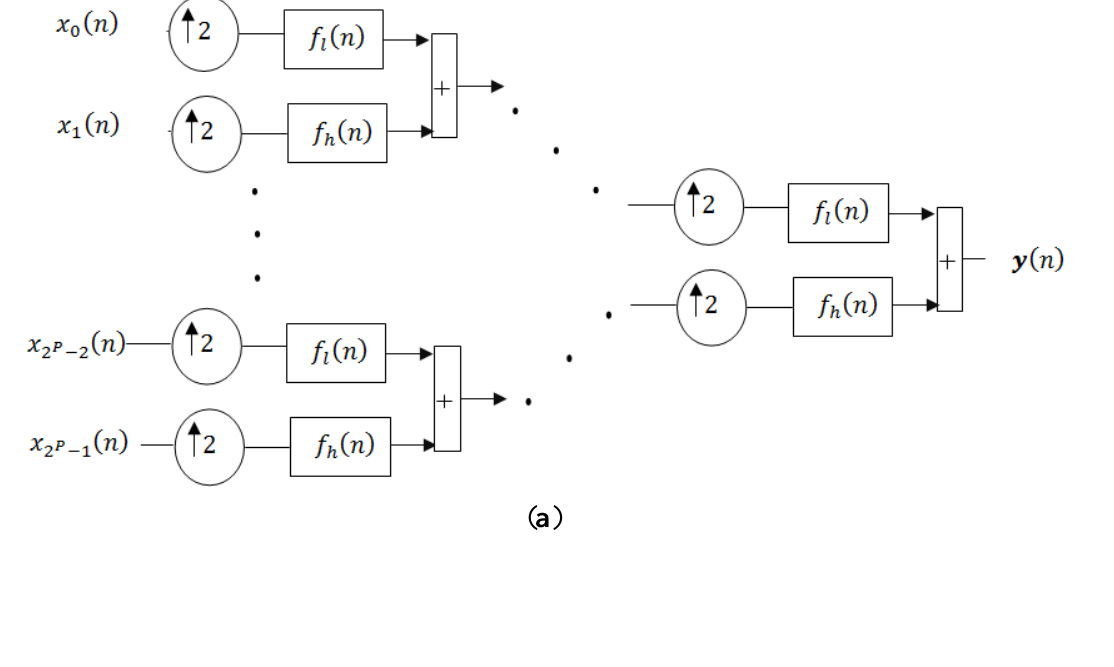
Figure 1. Symmetric multistage WOFDM modulator and demodulator. ( a ) Symmetric multistage synthesis side QMF bank; ( b ) Symmetric multistage analysis side QMF